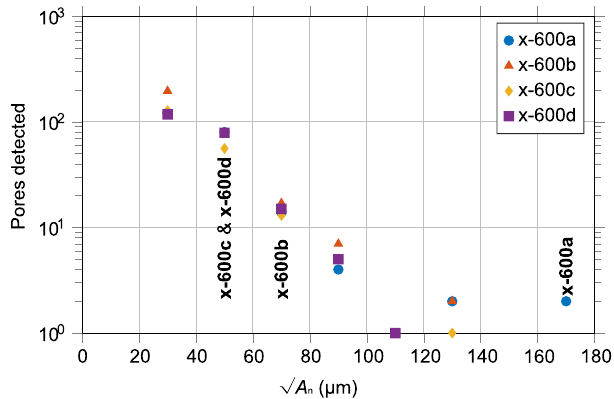
Figure 4. Pore size distribution - Detected by CT in each of the four fatigue samples ~270 mm 3 gauge volumes prior to testing in the x -direction (note log scale). The sample designations (bold) indicate the size of the crack initiating pore for the respective samples.